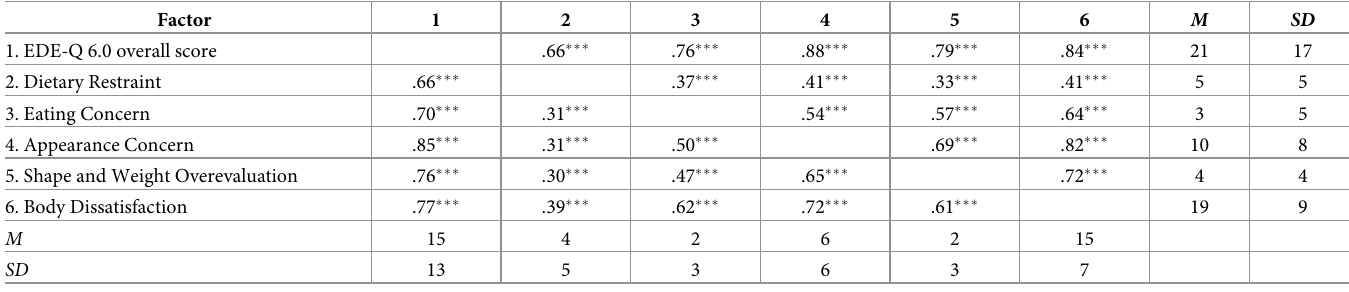
Note . Correlations in women are shown above diagonal, whereas correlations in men are presented below diagonal. Means and standard deviations for women are shown in the two last columns, and means and standard deviations for men are in the two last rows. ��� p <